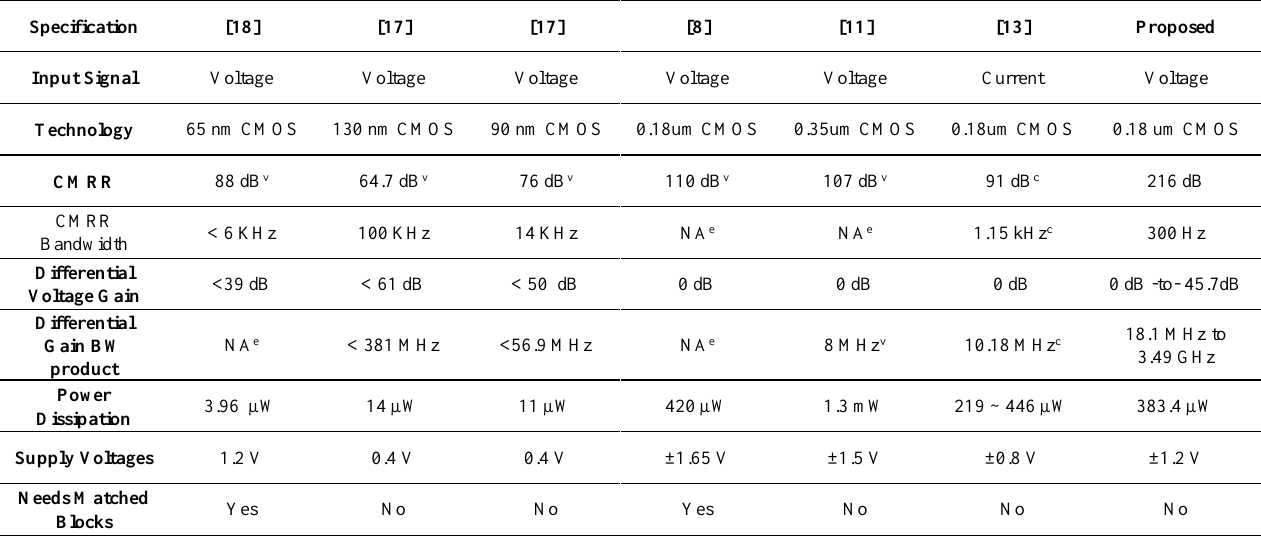
Table 3 . Comparison between the proposed CMIA and some other